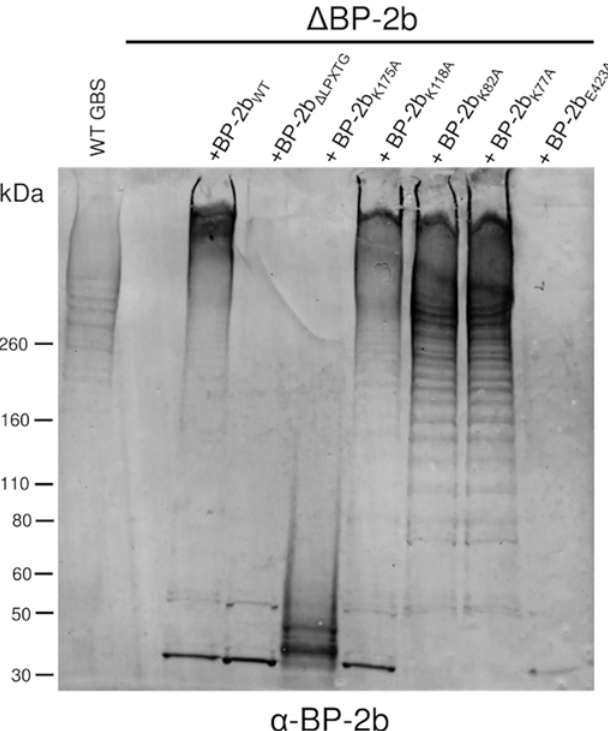
Fig 4. Lys 175, Glu 423 and the sorting motif LPSTG are involved in BP-2b polymerization in GBS. Immunoblot analysis of total protein extracts from GBS mutant strain lacking the pilus 2b backbone protein gene ( Δ BP-2b ) complemented with plasmids expressing the wild-type BP-2b protein (WT) or BP-2b mutants carrying a deletion of the C-terminal sorting signal (BP-2b Δ LPXTG ), alanine substitutions of the putative pilin motif lysine (BP-2b K175A , BP-2b K118A BP-2b K82A ) or of the E-box E423 residue (BP-2b E423A ). Nitrocellulose membrane was probed with a mouse antiserum raised against the recombinant BP-2b protein ( α -BP – 2b).